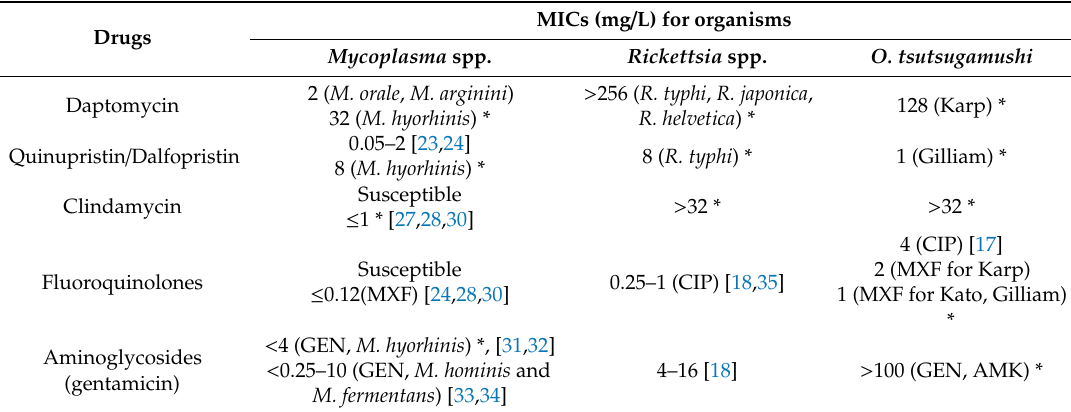
Table 1. MICs (mg / L) of Di ff erent Antibiotics for Mycoplasma spp., Rickettsia spp., and Orientia